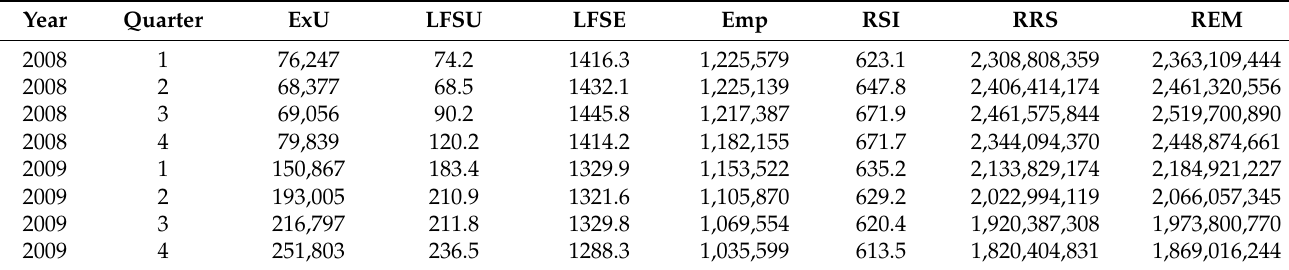
Table A1. Data set for the case study